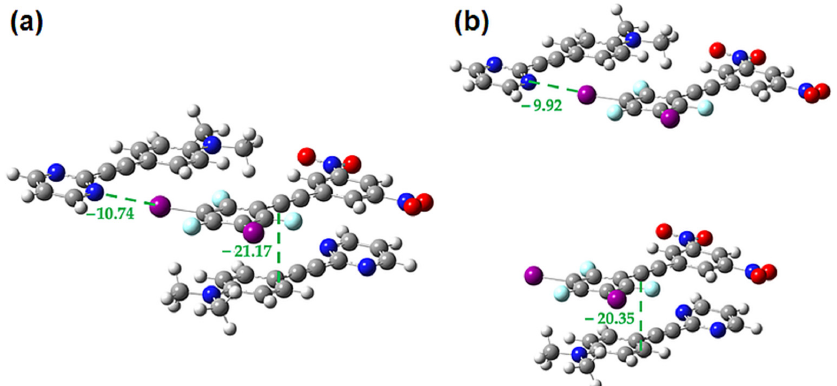
Figure 19. M062X-D3/DGDZVP interaction energies (in kcal/mol) in the 2•3 cocrystal for the interplay between the face-to-face 2-3 π -stacking and the linear halogen bond ( a ) within trimer ( b ) in the isolated dimers.